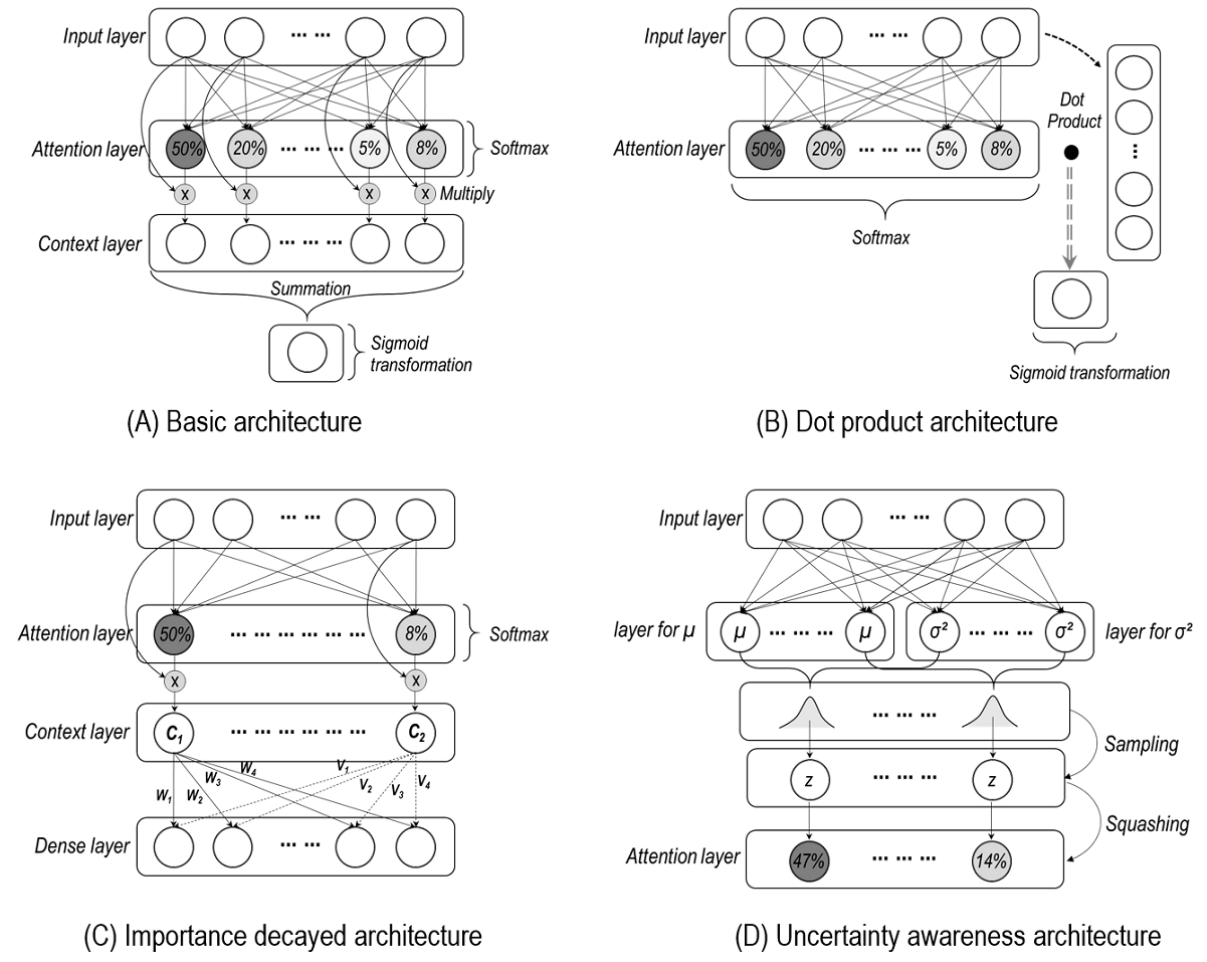
Figure 1. Model structures for attention implementation. (A) Basic architecture of an attention mechanism model. (B) Model architecture where the dot product is employed for transferring the influence of input variables toward the outcome. (C) Model architecture where the importance of input variables may be decayed. (D) Model architecture that is aware of uncertainty. The percentages in the circles show examples of attention